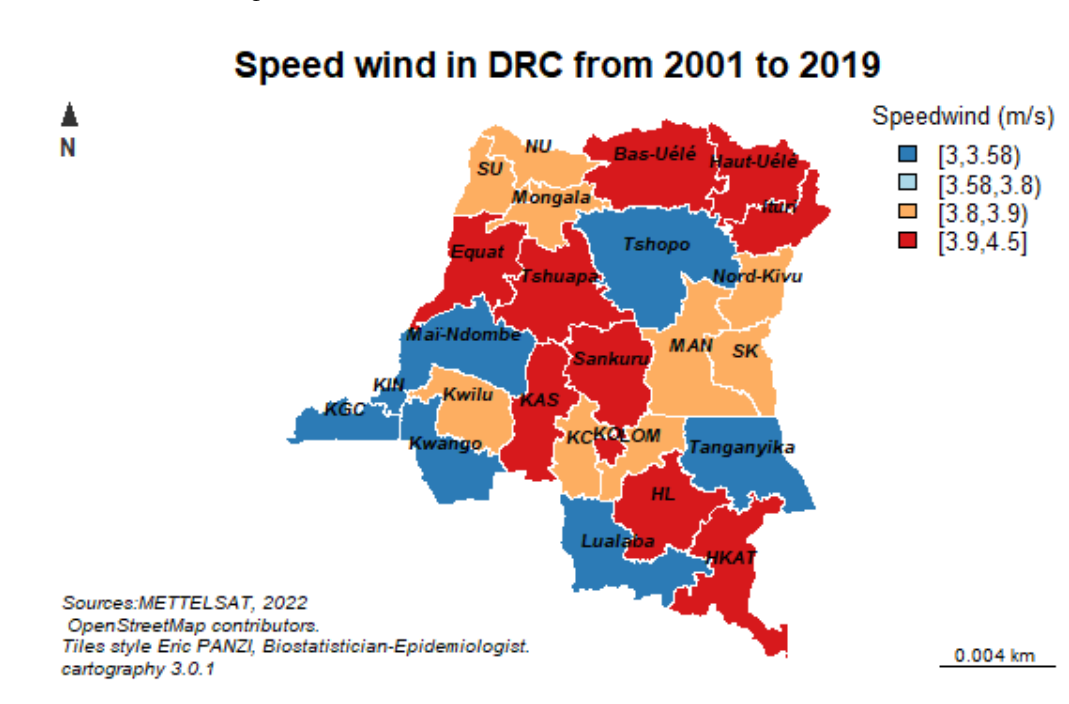
Figure A9. Total rainfall (mm) in DRC from 2001 to 2019.